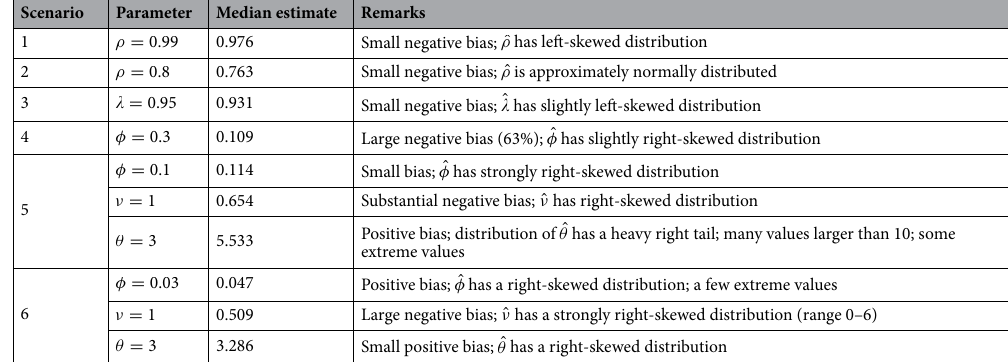
Table 3. Results for nuisance parameters for the simulation scenarios described in Table